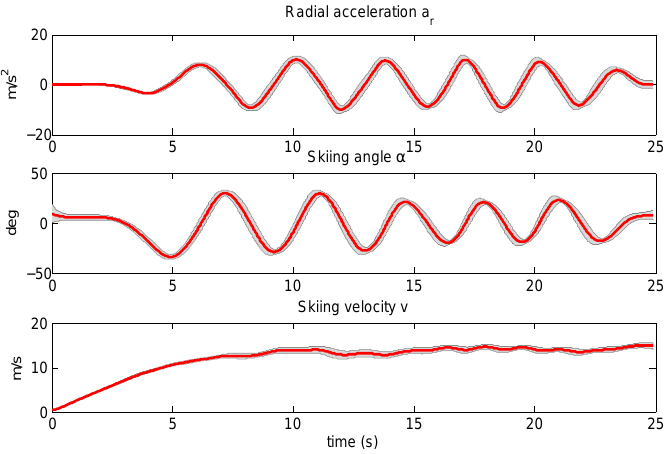
Figure 10. Mean values of query data composed of radial acceleration a and skiing velocity v for all 18 ski runs. The shaded region denotes the standard deviation.